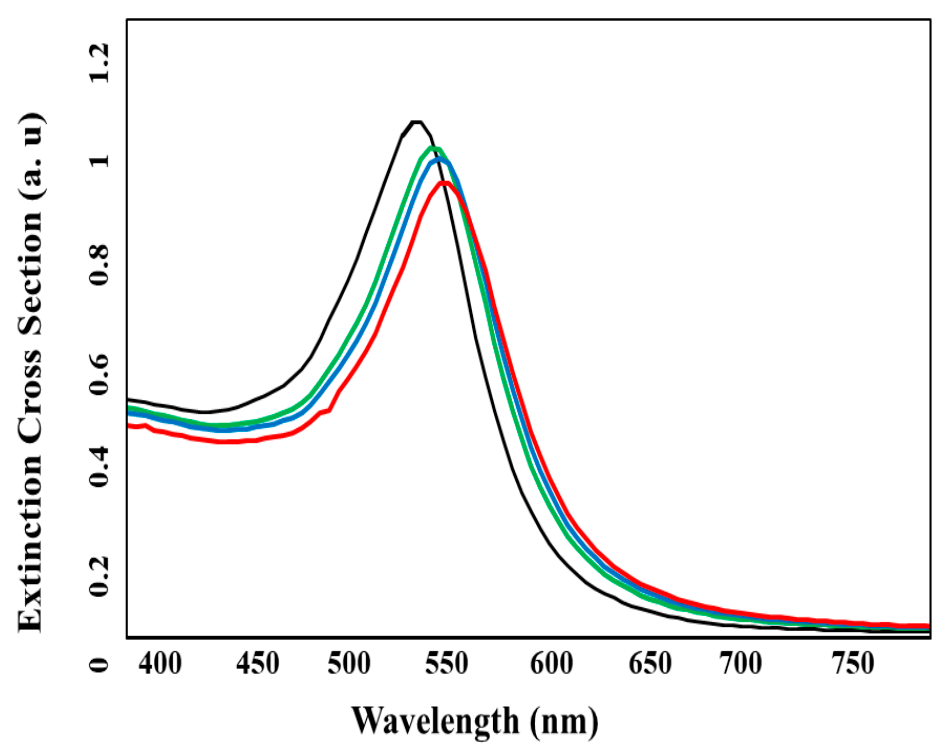
Figure 8. The label-free biosensing of anti-NS1 antibody to NS1 antigen using colloidal Au nanosphere suspension. (Black Curve—AuNP, Green Curve—Au—Cysteamine, Blue Curve—Au—Cysteamine—Antibodies, Red Curve—Antigen Detection).